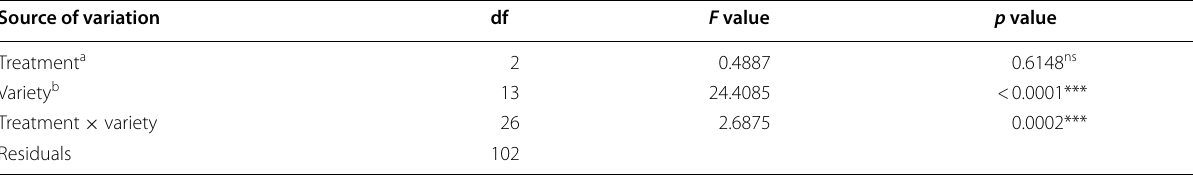
a N0, N50, N200 b TN1, IR24, NIL- BPH4 , NIL- BPH9 , NIL- BPH10 , NIL- BPH17 , NIL- BPH18 , NIL- BPH20 , NIL- BPH21 , NIL- BPH26 , NIL- BPH32 , NIL- BPH2 ns no significance, *** p value <